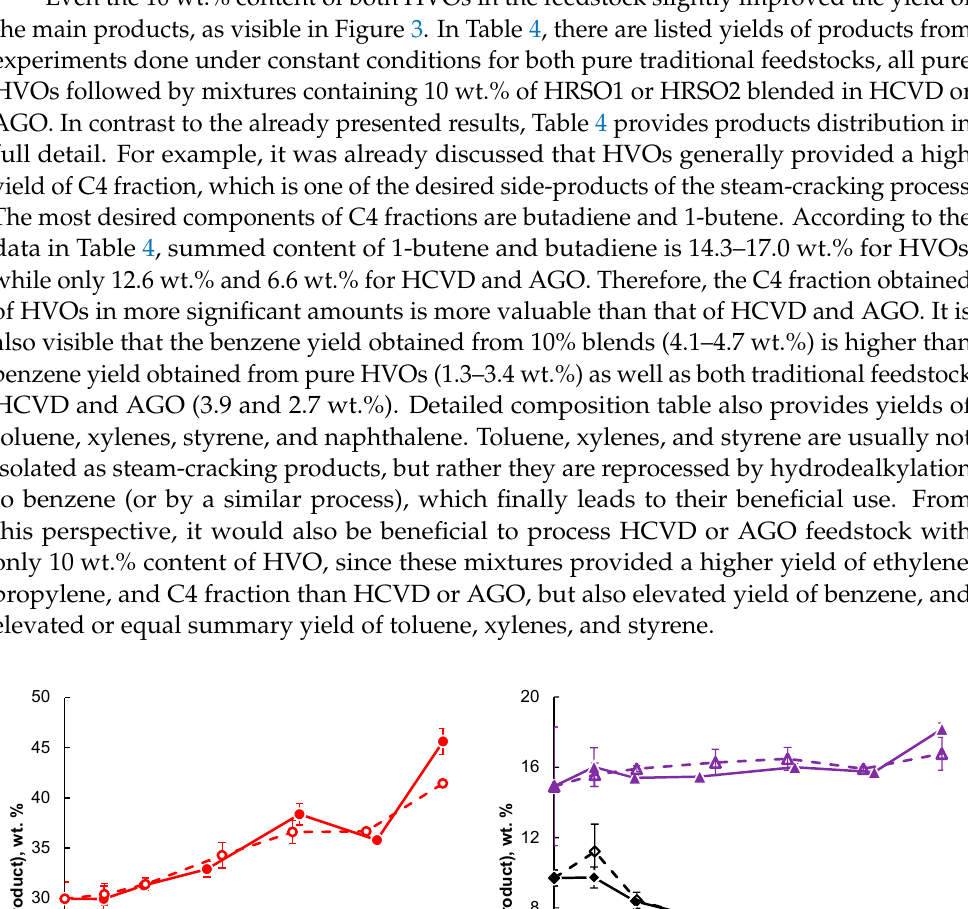
Figure 3. Pyrolysis products yield obtained under constant reaction conditions (400 kPa, 800 °C, 65 NmL/min) in dependence on the HRSO1 (solid, filled) or HRSO2 (dashed, empty) content in feedstock blended in HCVD. Left : ○● ethylene, ▲∆ propylene , Right : ▲∆ C4 fraction, ■□ C4 Benzene , ♦◊ Oil. Table 4. Products distribution (in wt.%) obtained at 800 °C, under 400 kPa and 65 NmL/min for pure traditional feedstocks (HCVD and AGO), pure HVOs (HRSO1, HRSO2, HRSO3, HSFO and HUCO) and blends containing 10 wt.% of HRSO1 or HRSO2 in HCVD or AGO.